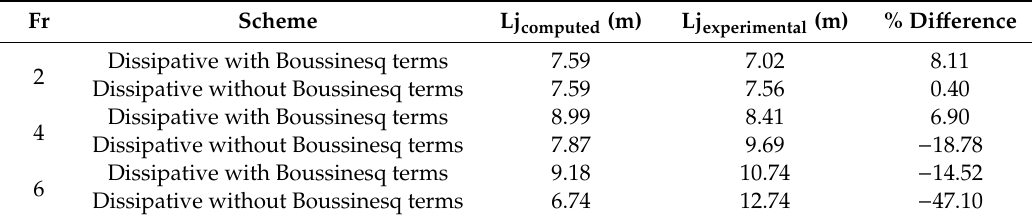
Table 4. Length of jump for 5 m wide open